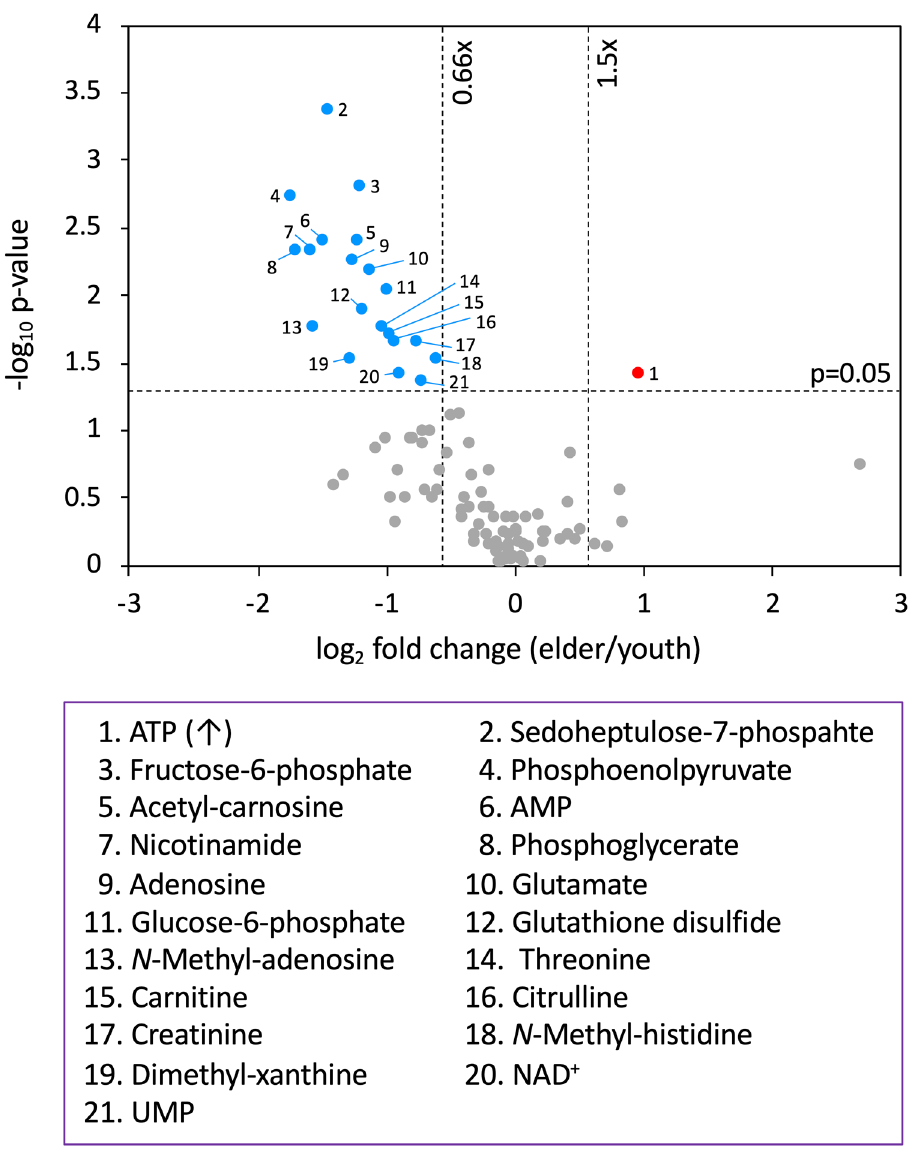
Figure 1. Volcano plot showing different levels of salivary metabolites in young and elderly subjects. The x-axis is the log2 fold change, whereas the y-axis is the -log10 p value of the Mann Whitney U-test. Two vertical dashed lines show the border of 0.66- and 1.5-fold change, respectively. The horizontal dashed line shows a p value = 0.05. Plots represent significantly higher (red), lower (blue), and unchanged metabolites (gray) in the elderly group. Twenty-one metabolites manifesting age differences are listed in the purple